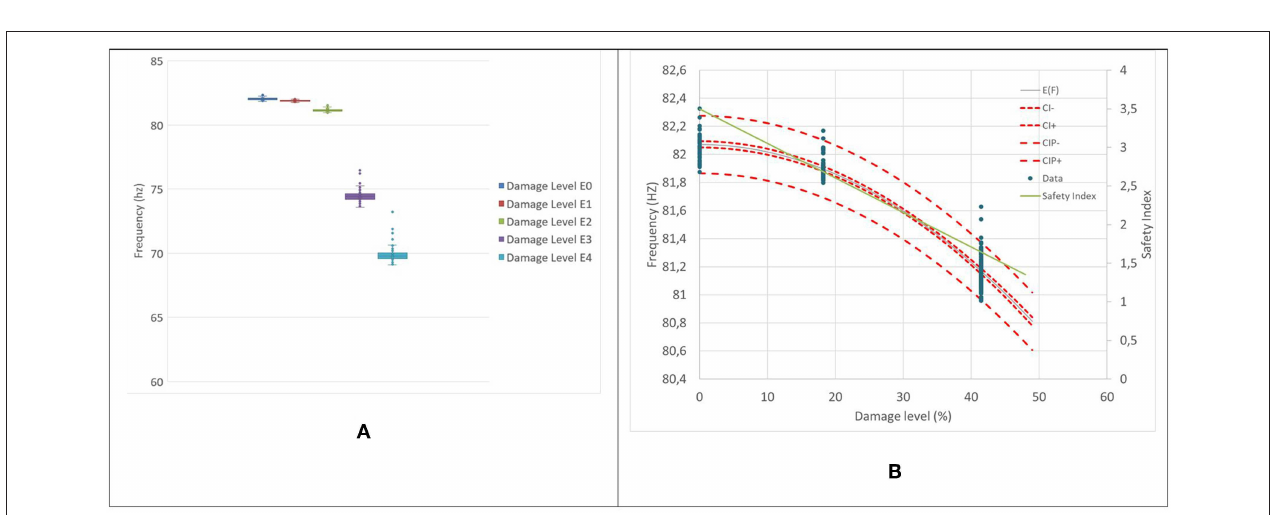
FIGURE 5 | Damage located at 0.65L. (A) Whisker plot of the frequency of the first mode of vibration at 5 damage levels, (B) Linear regression of frequency as a function of damage level (Damage levels E 0 , E 1 , and E 2 ).